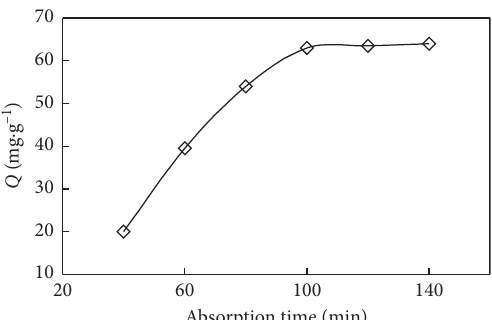
Figure 1: Effects of absorption time on Cu 2+ absorption